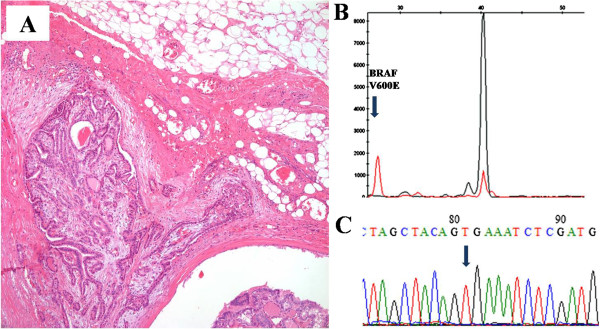
A papillary thyroid carcinoma with discrepant BRAF mutation results in STA fragment analysis and direct sequencing. (A) Pathology showing extrathyroidal extension. (B)BRAF mutation detected by STA fragment analysis. (C) Sequencing result showing wild-type for BRAF mutation.